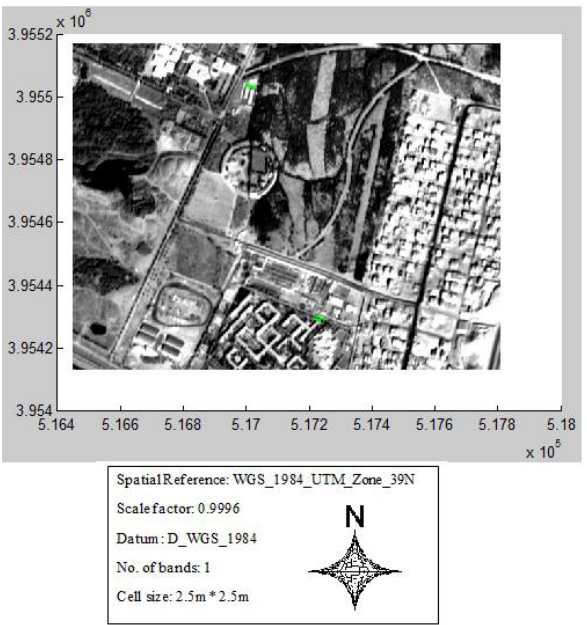
Figure 4. The first geo-referenced image of the study area acquired at June 3, 2010